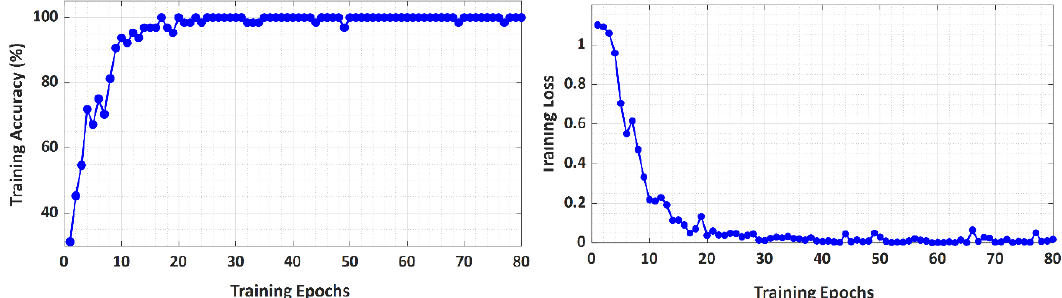
Figure 8. Convergence curves of the fault type detection unit during the training process.